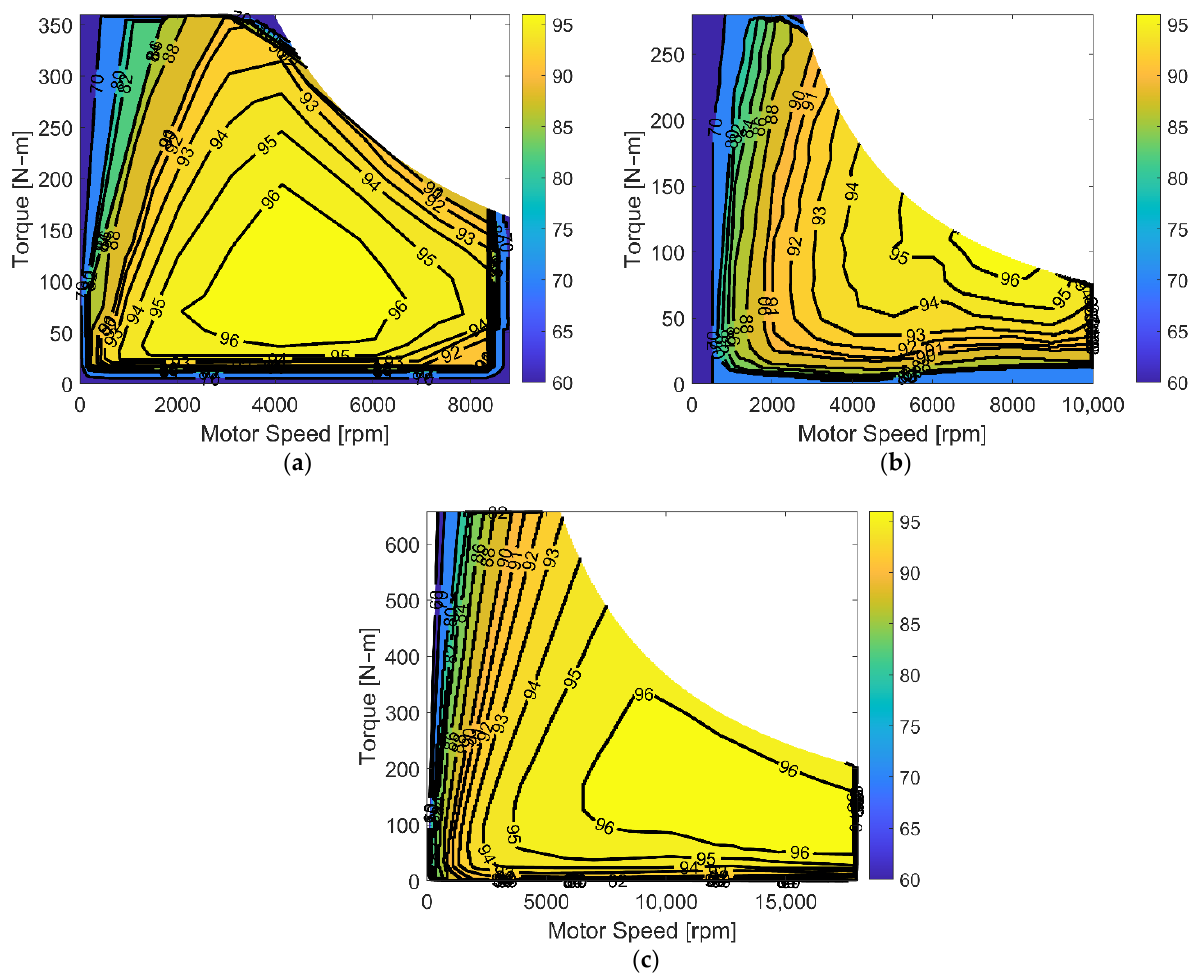
Figure 3. Digitized motor efficiency maps for ( a ) permanent magnet synchronous motor A, ( b ) permanent magnet synchronous motor B, and ( c ) induction motor. Near the origin and out of the maximum power area, a few values were estimated due to limits of the digitization process. Contour lines are indicated at 60%, 70%, 80%, 82%, 84%, 86%, 88%, 90%, 91%, 92%, 93%, 94%, 95%, and 96% efficiency